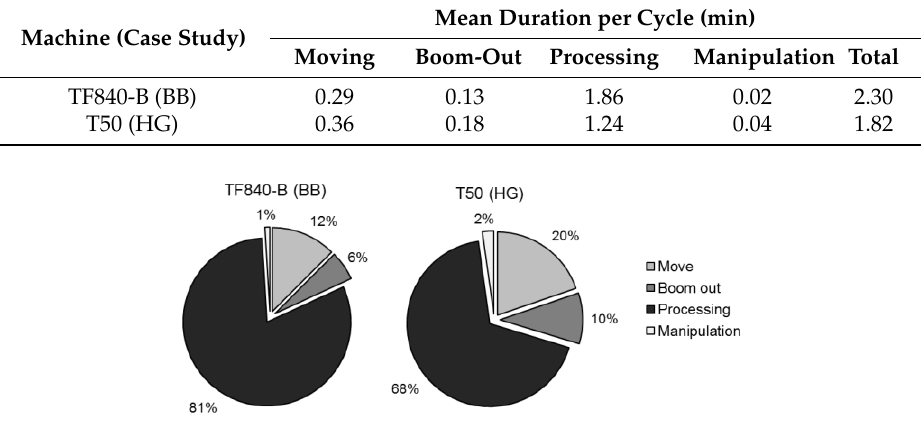
Table 6. Mean duration of work elements per cycle (i.e., tree) in the motor-manual (MM) group. Machine (Case Study)